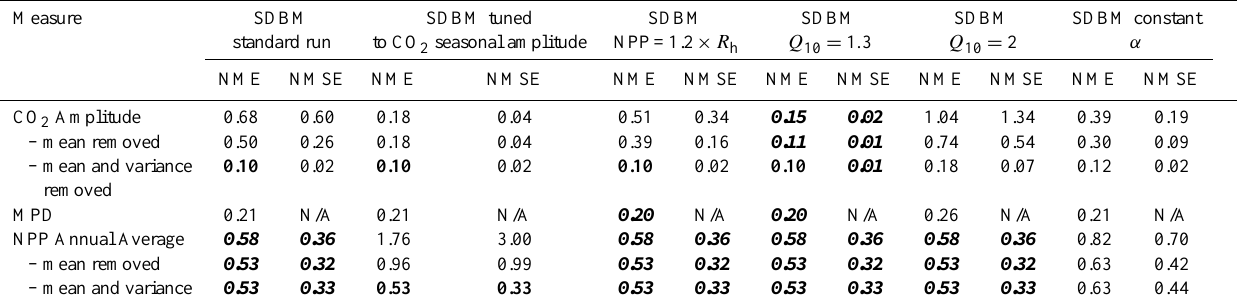
Table 7. Comparison metric scores for simulations with the Simple Diagnostic Biosphere Model (SDBM) against observations of the seasonal cycle of atmospheric CO 2 concentration and annual average NPP. Numbers in bold indicate the model with the best performance for that variable. Italic indicates model scores better than the SDBM simulation tuned using CO 2 seasonal observations. NME/NMSE denotes the normalised mean error/normalised mean squared error and MPD the mean phase difference. The details of each experiment are explained in the